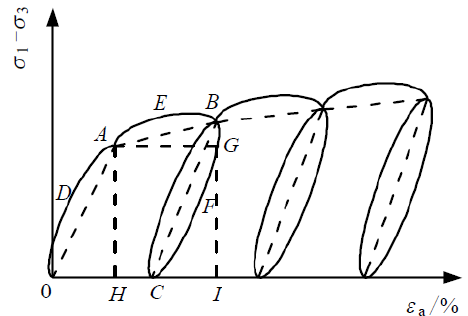
Figure 10. Simplified form of repeated loading and the stress-strain relationship.